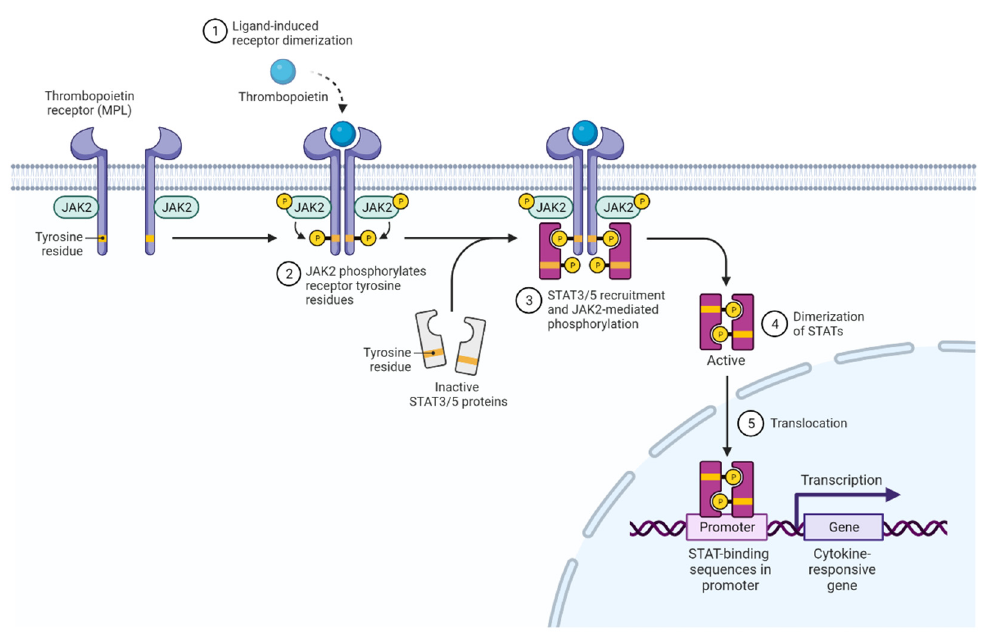
Figure 2. The JAK-STAT signaling pathway in MPN. Activated JAK2 mediates phosphorylation of its cognate receptors at the cytoplasmic tail and the generated phosphotyrosines serve as docking sites for SH2 domain-containing signaling proteins such as the signal transducer and activator of transcription (STATs). In MPN, STAT3 and STAT5 are phosphorylated, dimerize and translocate to the nucleus to regulate transcriptional programs, promoting cell proliferation, differentiation, and survival [3,13].